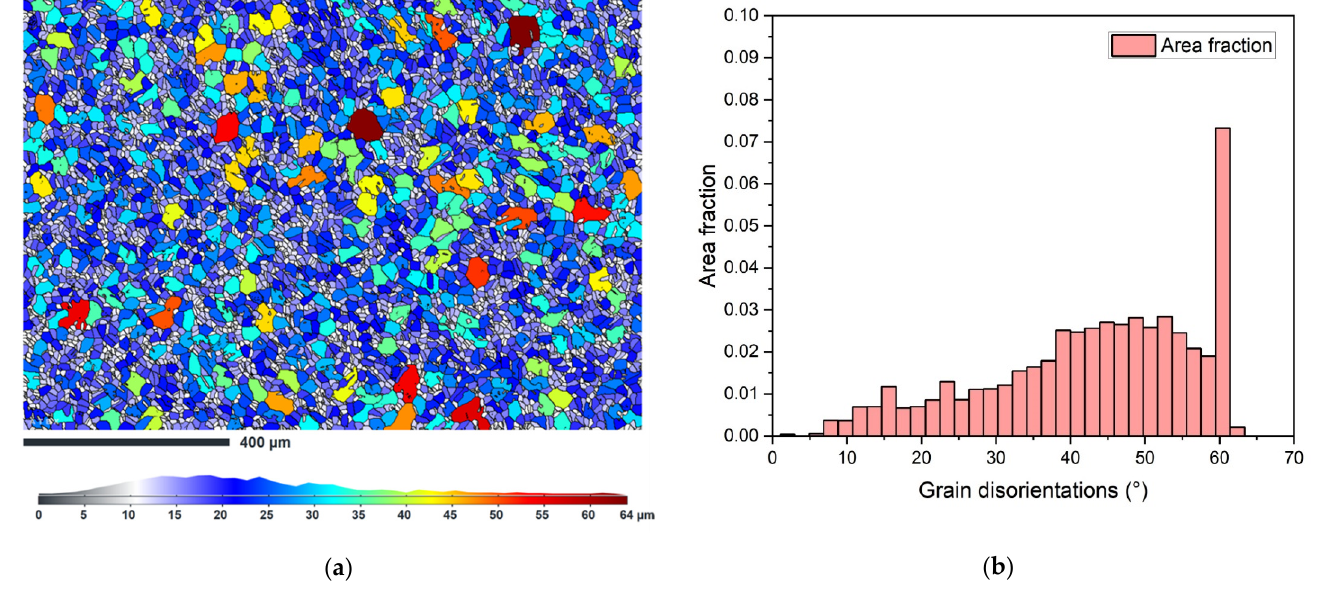
Figure 9. ( a ) Grain size map of the sample as-received, longitudinal section; ( b ) total area fraction of the disorientation of the grain boundaries.